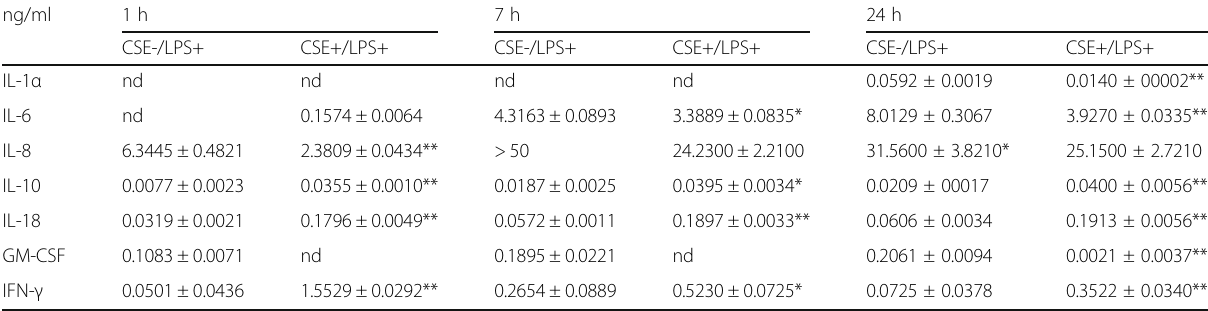
Table 2 Levels of cytokines/chemokines in culture medium of pAECs stimulated with LPS (10 μ g/ml) in the presence or absence of Cucumis sativus L. extract (CSE 2 mg/ml). Data shown are representative of at least three independent experiments and represent the mean ± SEM. Significant differences are indicated by ( p < 0.05) *, and ( p < 0.001) by ** nd not detectable ng/ml 1 h 7 h 24